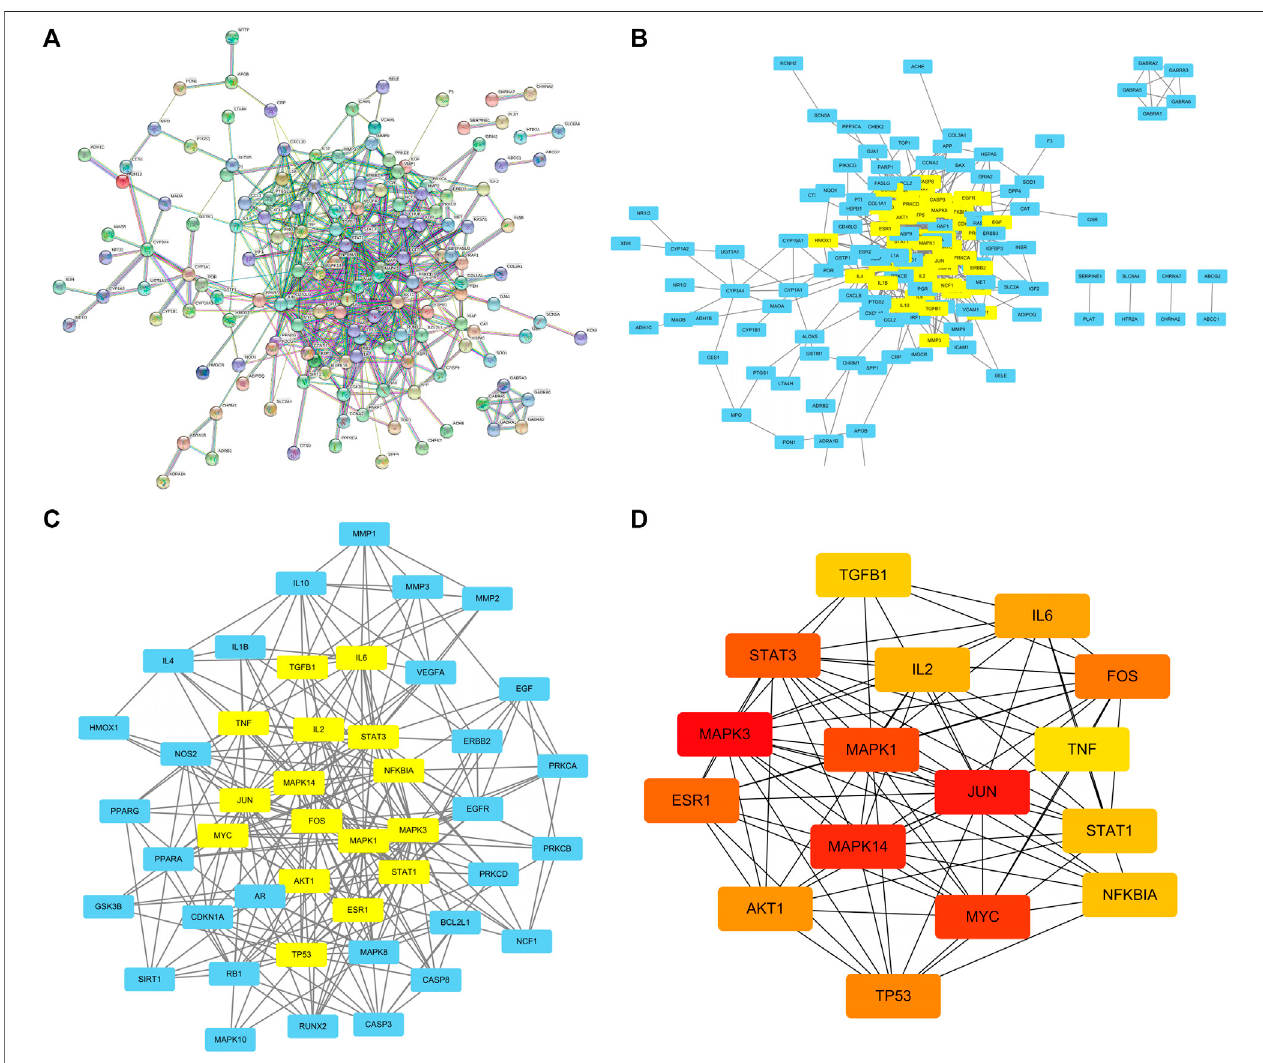
FIGURE 7 | PPI network of DZXY- depression obtained from STRING database (A) , PPI network imported from STRING database to Cytoscape 3.9.0 (B) , PPI network of core genes by fi ltering 6 parameters: BC, CC, DC, EC, NC, and LAC (C) , and the top 16 MCC gene nodes (D) , respectively.